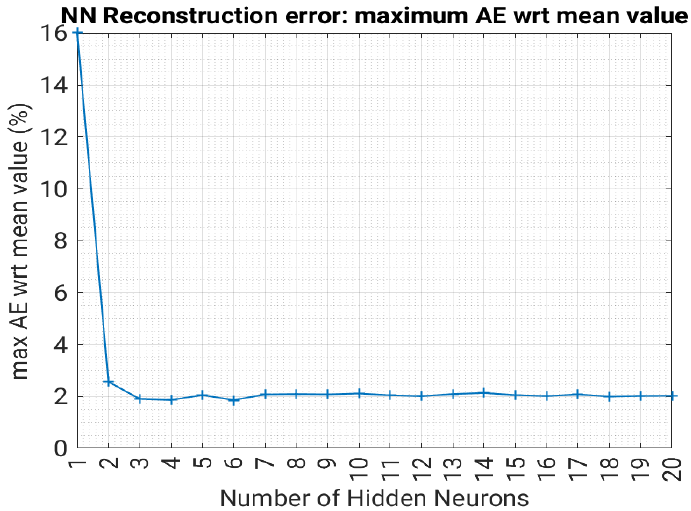
Figure 6. Reconstruction error as a function of the number of neurons for Dataset 3.